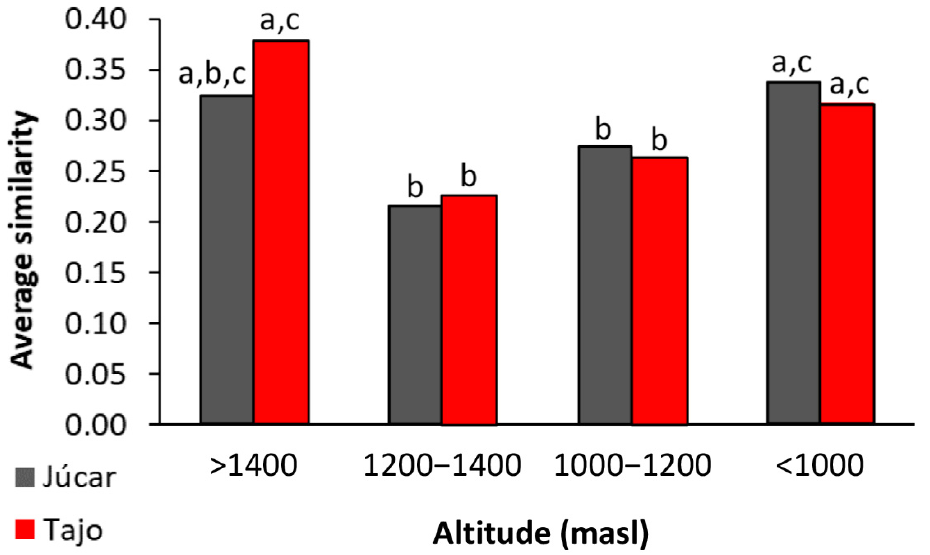
Figure 2. ANOSIM (on Bray–Curtis index) comparisons of BD taxa relative abundances regarding altitudinal patterns vs. large catchments of the Serranía de Cuenca (Spain) in summer 2017. The coefficient of variation ranged from 95 to 120; error bars are not included because they complicate the figure. Mann–Whitney pairwise comparisons (Bonferroni corrected, p < 0.001) are indicated by lower-case letters.